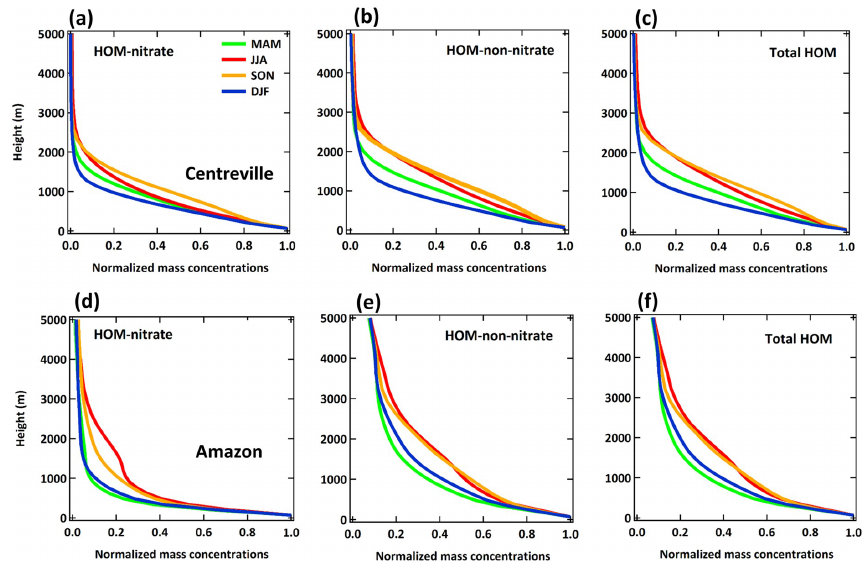
Figure 10. The seasonal averaged vertical profiles of HOM-ON (a, d) , HOM-non-ON (b, e) , and total HOMs (c, f) at the Centreville (a–c) and Amazon (d–f) sites. All of the results are from the LowProd_Photo experiment. Values are normalized to the lowest-level values of each season. The profiles with absolute concentrations are shown in Fig.